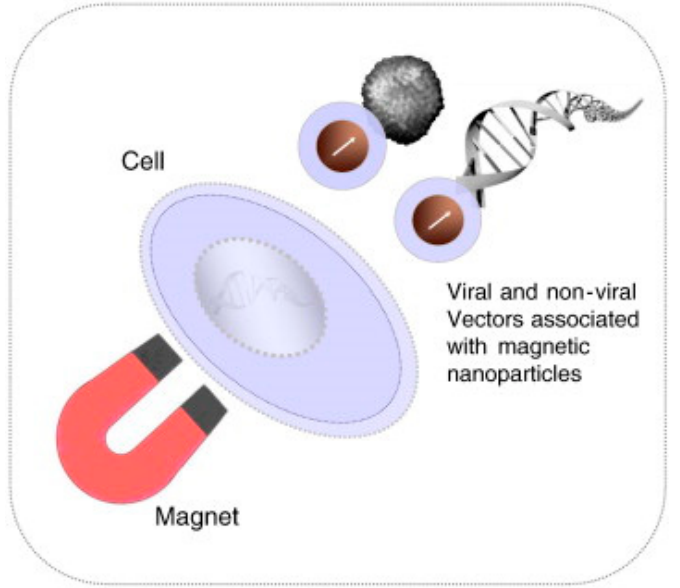
Figure 24. Schematic diagram of the Magnetofection process. Reprinted with permission from ref. [159]. Copyright © 2011 Elsevier.